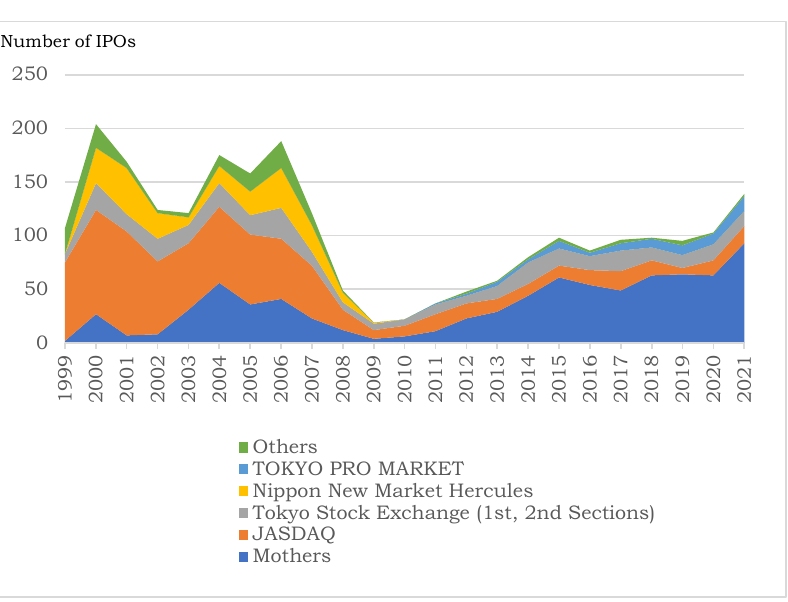
Figure 1. Changes in the number of